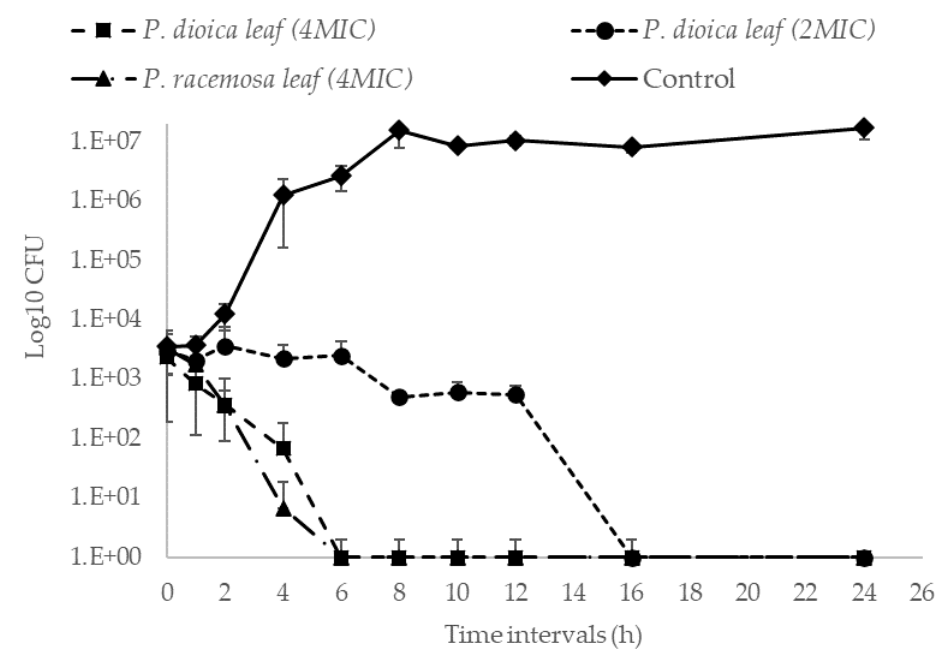
Figure 3. The killing kinetics of Pimenta dioica and Pimenta racemosa leaf essential oils tested against AB-8 isolate. ( ) P. dioica leaf E.O. tested at concentration of 2.0 µg·mL − 1 (4× MIC), ( ) P. dioica leaf E.O. tested at concentration of 1.0 µg·mL − 1 (2× MIC), ( ▲ ) P. racemosa leaf E.O. tested at concentration of 2.0 µg·mL − 1 (4× MIC). Data is represented by means of the number of recovered colonies counted at each time point ± SD, n = 3.